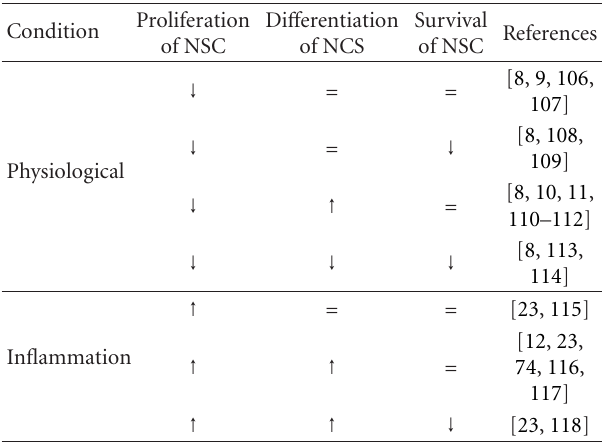
Table 2: Regulation of adult neurogenesis by NO under physiolog- ical or inflammatory